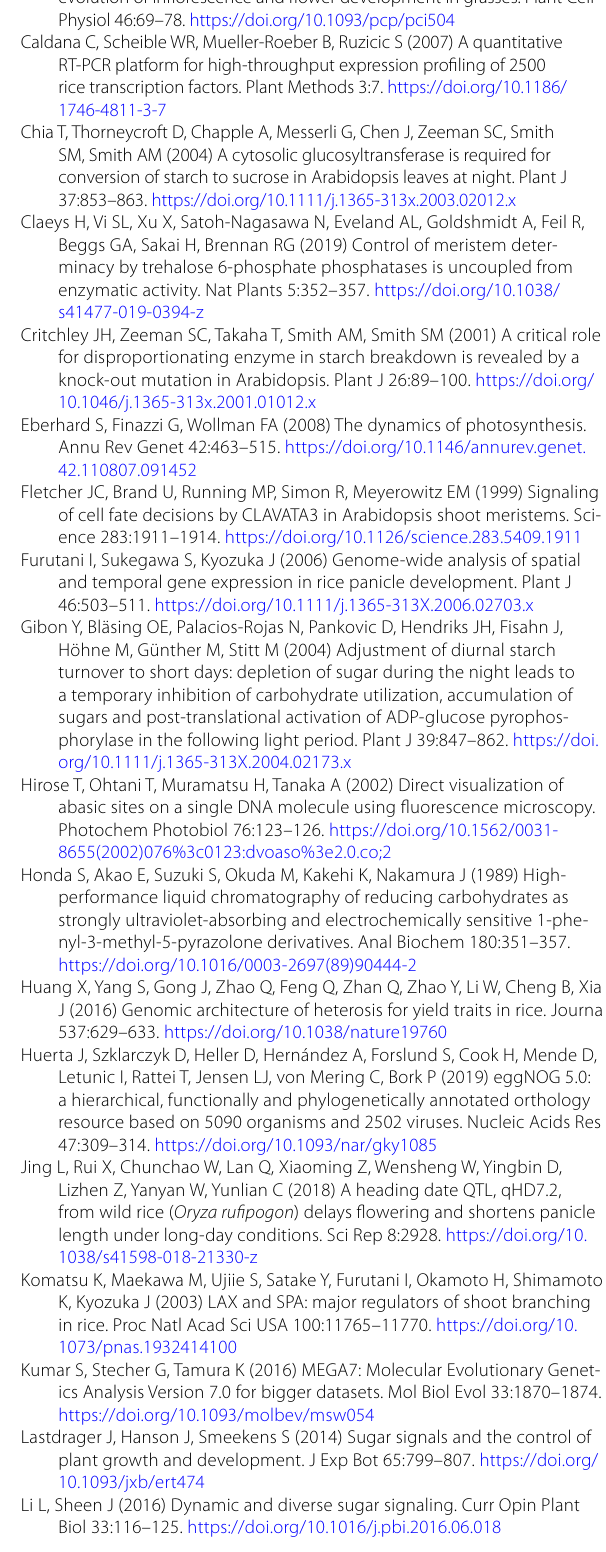
Additional file 5. Fig. S1 : T-DNA mutants of LAX1 in ZH11. Fig. S2 : Mutant plants were screened out to observe and analyze their panicle phenotype after identifying their lax1-6 locus. Fig. S3 : Genotypic identification and phenotypic observation of the recombinants identified between S5 and S8 using the progeny test. Fig. S4 : The progenies of the OsDPE2-Com T 1 in the lax1-6 background were subjected to phenotypic analysis and positive transgenic detection. Fig. S5 : The progenies of the OsDPE2-Com T 1 in the lax1-3 background were subjected to phenotypic analysis and positive transgenic detection. Fig. S6 : Panicle and plant phenotypic characteristics of Dular and osdpe2 Dular (H). Fig. S7 : Growth rate analysis and DPE2 enzyme activity analysis of the plants under continuous light (CL) and continuous dark (CD) conditions. Fig. S8 : Panicle phenotypic characteristics analysis of the 12 allelic OsDPE2 mutants. Fig. S9 : Iodine staining analysis of starch in various vegetative organs of wild-type and osdpe2#01 . Fig. S10 : Haplotype evolution and evolutionary analysis of OsDPE2 locus. Fig. S11 : Starch assay and bound the recombinant proteins to OsDPE2 haplotypes. Fig. S12 : The binding of recombinant proteins to the maltose assay of OsDPE2 hap- lotypes using differential scanning fluorimetry (DSF). Fig. S13 : Standard curve of endogenous OsDPE2 and transgene OsDPE2(AQ) ZH11